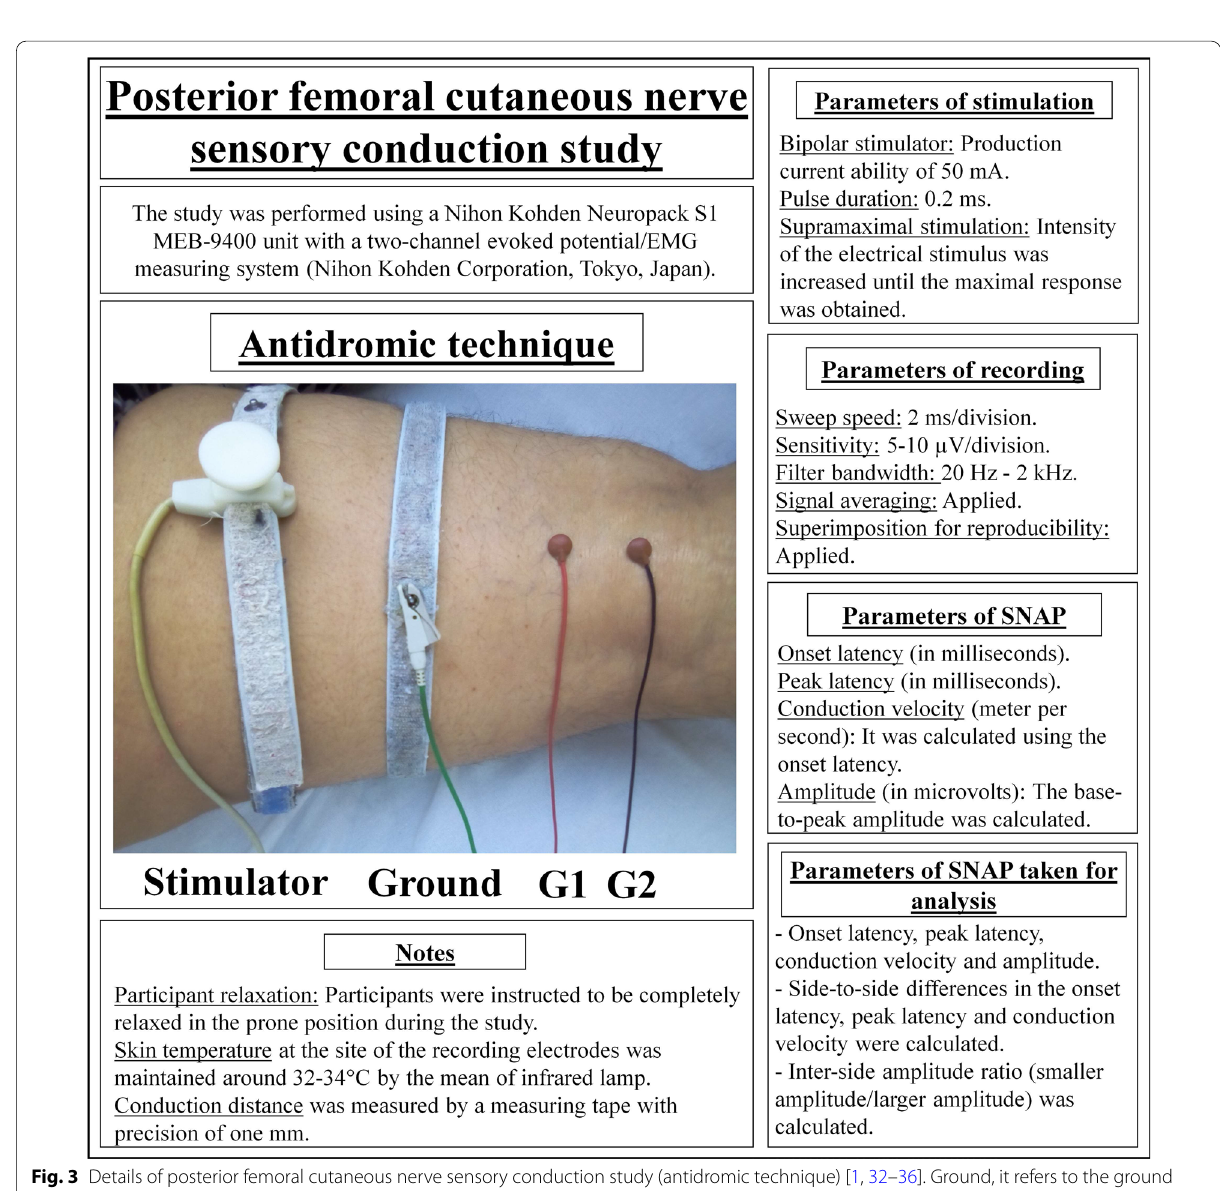
Fig. 3 Details of posterior femoral cutaneous nerve sensory conduction study (antidromic technique) [1, 32–36]. Ground, it refers to the ground electrode; G1, it refers to the active recording surface electrode; G2, it refers to the reference surface electrode; Stimulator, it refers to the electrical bipolar stimulator; SNAP, sensory nerve action potential; mA, milliampere; ms, millisecond; μV, microvolt; Hz, Hertz; kHz, kilohertz; mm,